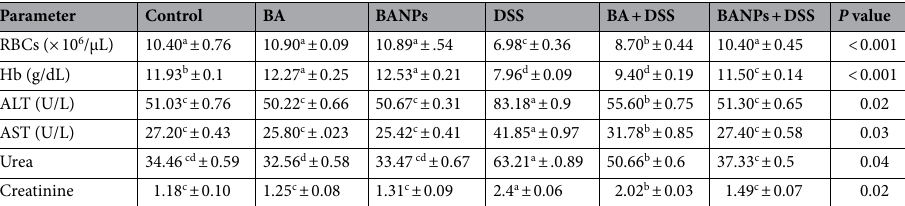
Table 2. Hematological, liver and kidney function tests of non-colitic and colitic rats orally administered B. amyloliquefaciens (BA) or BA-nanoparticles (BANPs). Non-colitic groups including Control, BA and BANPs groups where rats were orally gavaged PBS, B. amyloliquefaciens and B. amyloliquefaciens loaded nanoparticles (BA at level of 1.0 × 10 10 CFU/kg in 1 mL of PBS/rat/day), respectively, for 7 days. Colitic groups: DSS, BA and BANPs groups where rats were orally gavaged dextrane sodium sulphate (DSS), B. amyloliquefaciens + DSS and B. amyloliquefaciens loaded nanoparticles (BA at level of 1.0 × 10 10 CFU/kg in 1 mL of PBS/rat/day) + DSS, respectively, for 7 days. All groups orally gavaged by 5% DSS. RBCs red blood cells, Ht hematocrit, Hb hemoglobin, mean values with different letters in the same row differ significantly at P < 0.05, SE standard error. a,b,c Means of the bars with different letters were significantly different among groups (P < 0.05).